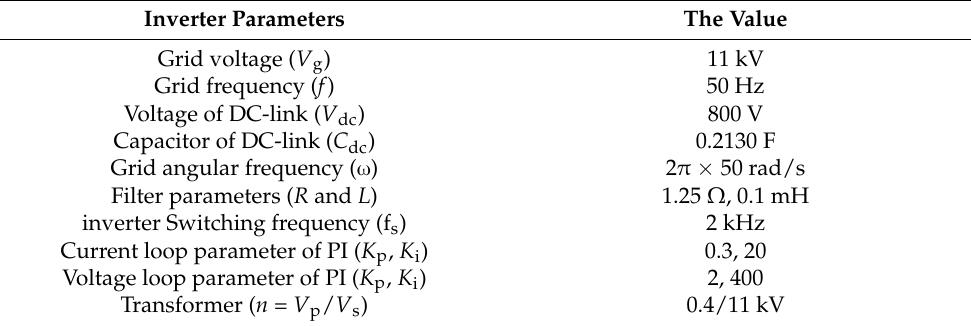
Table 2. Overview of the most important parameters of the inverter-connected power grid.